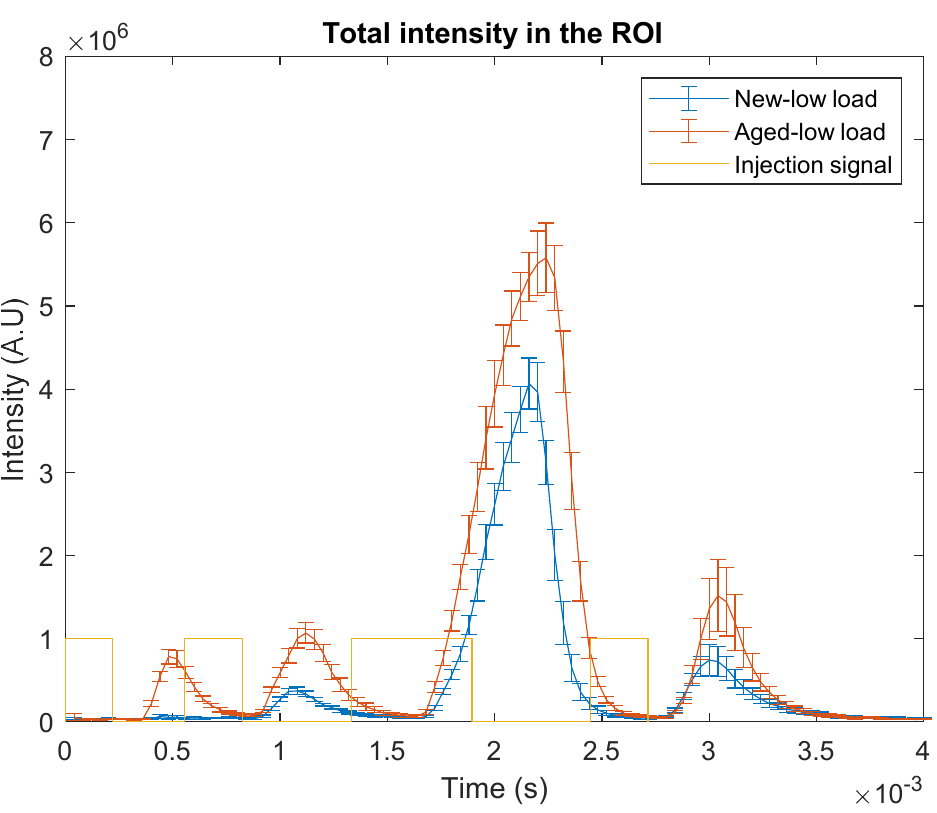
Figure 5. Mie-scattering signal at low load using different injectors.